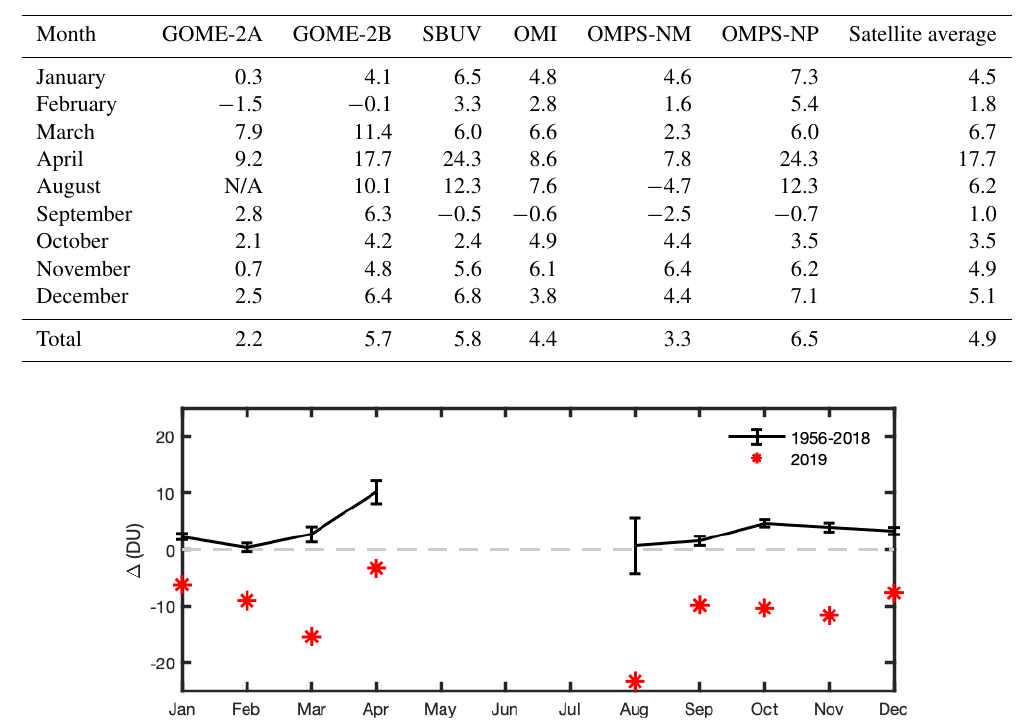
Table 2. Average absolute differences inDU between the total column of O 3 retrieved from the Halley Dobson instrument and those retrieved from the (raw) daily measurements by GOME-2A, GOME-2B, OMI, OMPS-NM, OMPS-NP, and SBUV averaged by month and in total for the period from 2013–2018.